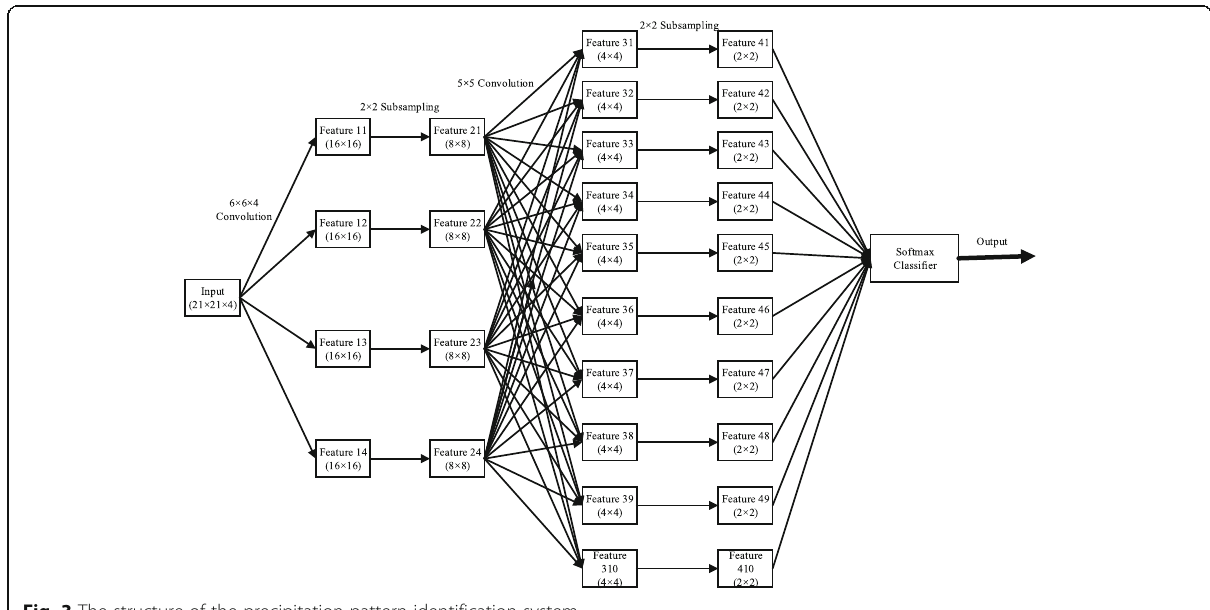
Fig. 3 The structure of the precipitation pattern identification system